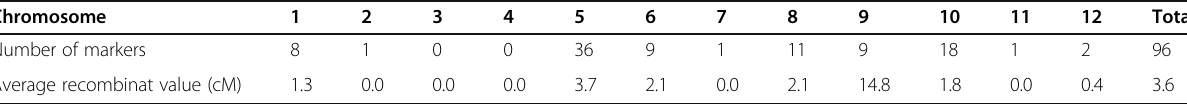
Table 2 Number of KASP and SSR markers on twelve chromosomes Chromosome Number of markers Average recombinat value